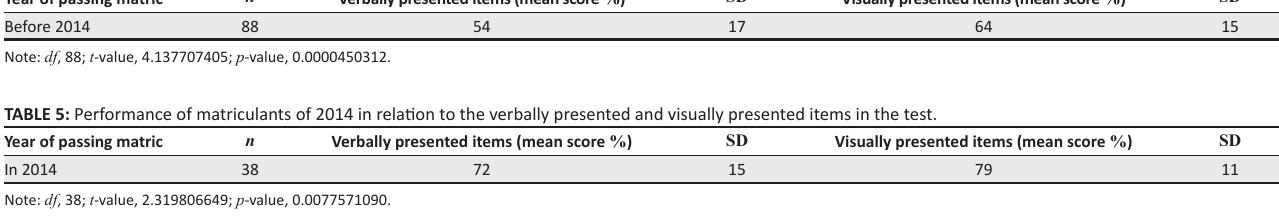
FIGURE 4: Performance of entry level mathematics education students in the multiple choice questionnaire according to TABLE 4: Performance of pre-2014 matriculants in relation to the verbally presented and visually presented items in the test. Year of passing matric n Verbally presented items (mean score % ) SD Visually presented items (mean score % ) SD